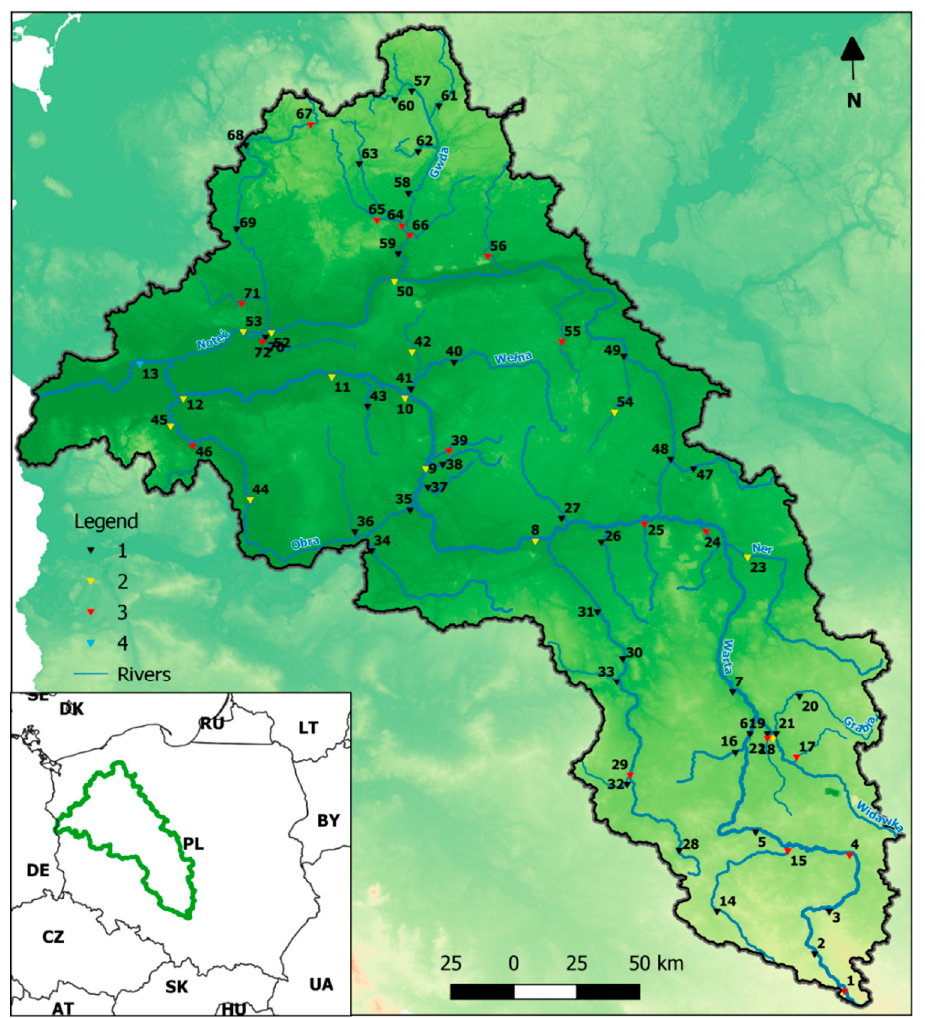
Figure 1. Location of water gauges in the Warta River catchment (numbering of gauges in accordance with Table 1): 1—gauges with full continuity of source data and with statistically insignificant trends in all analyzed periods, 2—gauges with full continuity of source data and with statistically significant trends in one or two analyzed periods, 3—gauges excluded from final analysis, i.e., gauges with incomplete source data or with statistically insignificant trends in all analyzed periods, 4—gauge Gorzów Wielkopolski closing the Warta River catchment. Basic data on the Warta River and its tributaries analyzed in terms of the synchronous and asynchronous occurrences of the runoff maxima are given in Table 1.